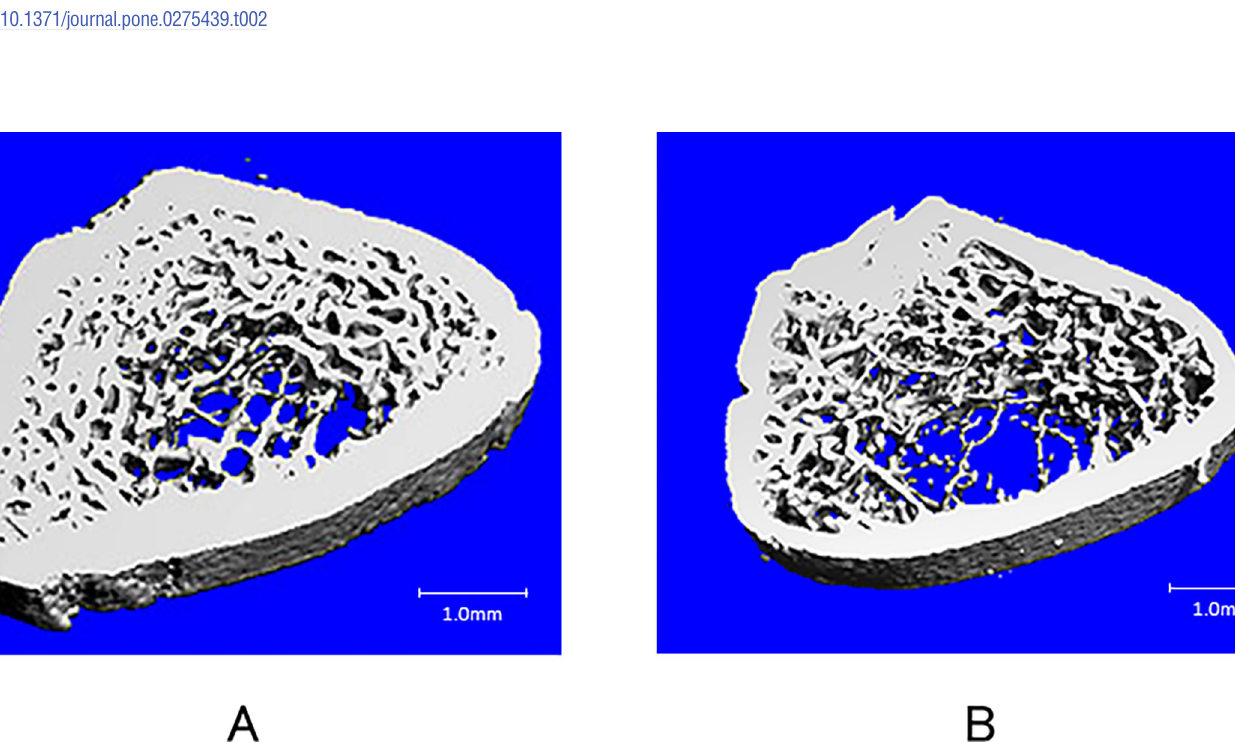
Fig 3. Typical 3D micro-CT images of the distal femoral metaphysis at week 12. Cortical bone was thin, and trabecular bone structures were smaller and fewer in the Im group compared to the control group. A: Control group; B: Im group. Scale bar = 1.0